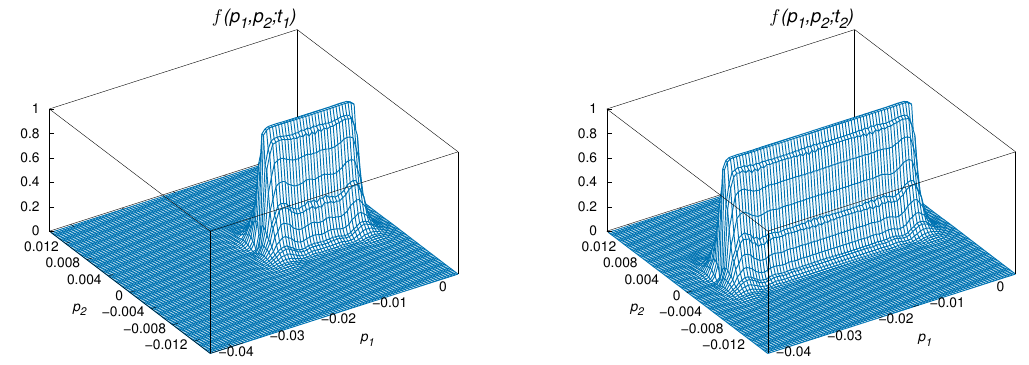
Figure 1. The distribution function in the 2 D momentum space for two consecutive points of time at the field strength 0.1 V/ µ m. Left panel : t 1 = 0.5